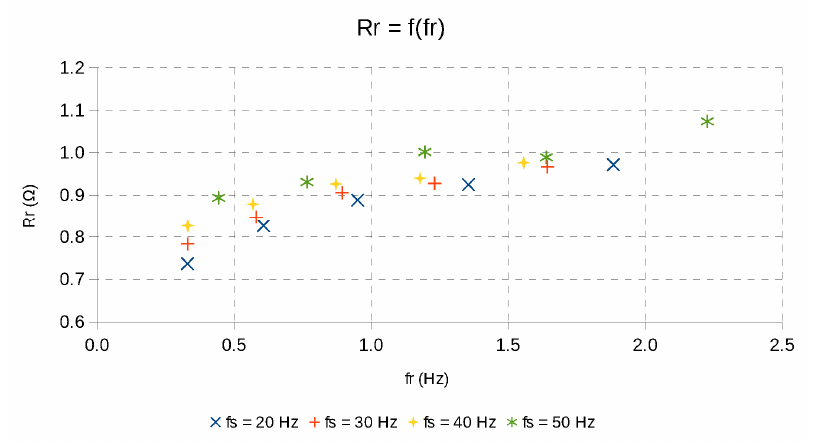
Figure 10. R r as a function of slip frequency f r for different stator frequencies f s .